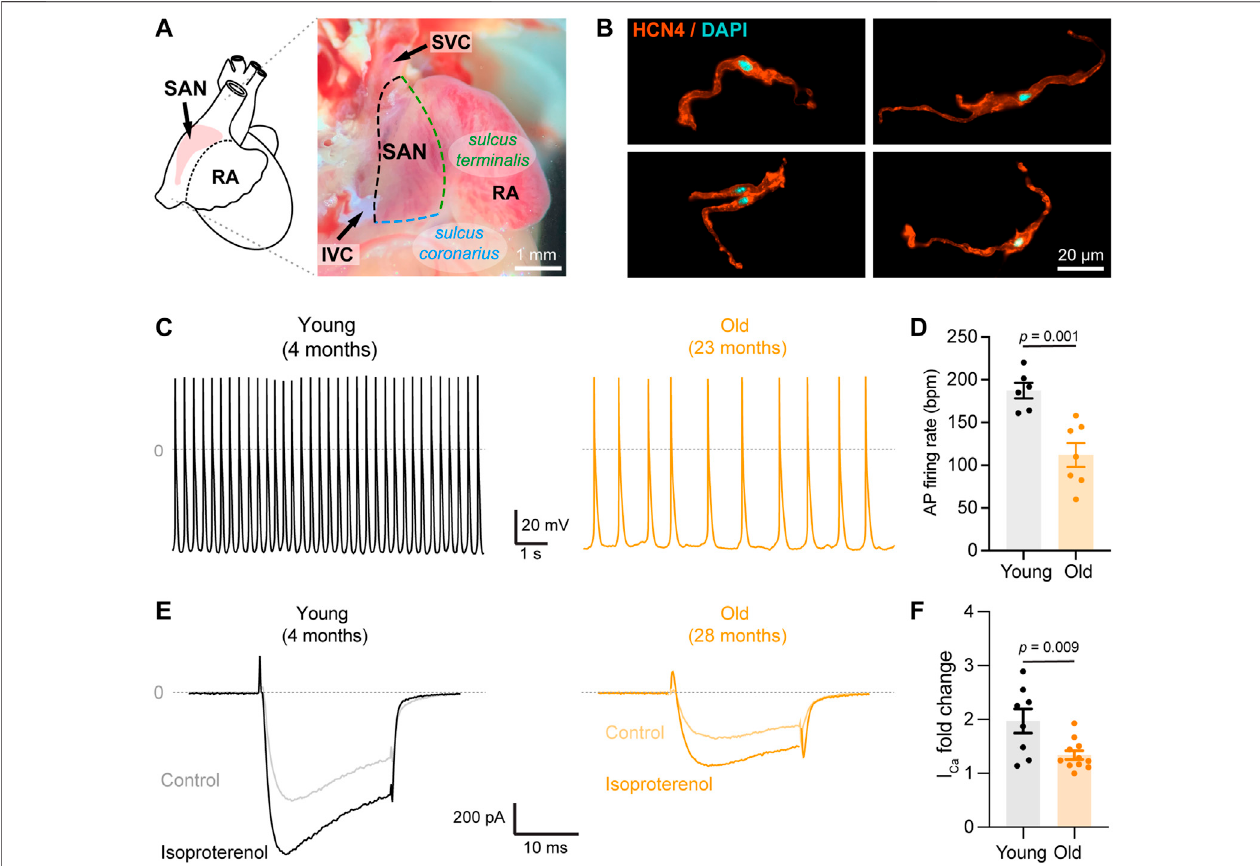
FIGURE1| Agingslowsdownactionpotential fi ringanddecreasesisoproterenol-mediatedupregulationofcalciumcurrents. (A) ( left )Schematicrepresentationof the position of the SAN pacemaker in the heart; (right) Image of the intercaval region of the mouse heart depicting the anatomical landmarks used to isolate the pacemaker explant. (B) Representative confocal images of isolated pacemaker cells immunostained against HCN4 (orange) and counterstained with DAPI (cyan). (C) Representative recordings of spontaneous fi ring of action potential from a young (gray) and old (orange) isolated pacemaker cell. (D) Comparison of the action potential fi ring rate in beats per minute (bpm) in young (n = 6, N = 3 animals) and old (n = 7, N = 4 animals) pacemaker cells. (E) Representative calcium currents from young ( left , gray) and old ( right, orange) cells, in the absence (light) or presence (dark) of 100 nM isoproterenol. (F) Fold-change of the calcium current peak after isoproterenol application in young (black, n = 10 cells, N = 3 animals) and old (orange, n = 12 cells, and N = 5 animals) pacemaker cells. Statistical comparison used an unpaired t-test with signi fi cance at p <